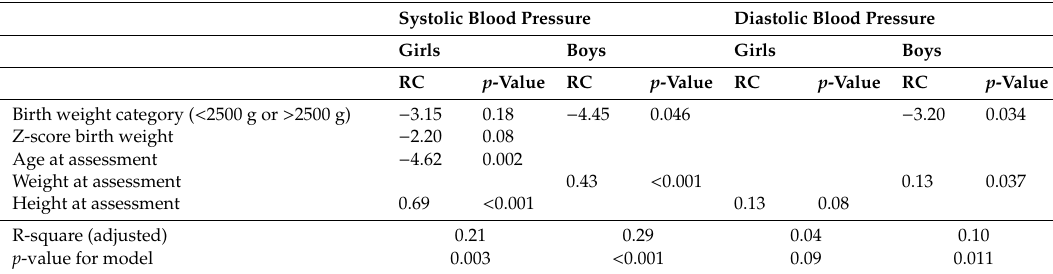
Table 3. Regression model for systolic and diastolic blood pressure for the whole cohort (preterm-born and control-term born study participants) by sex.